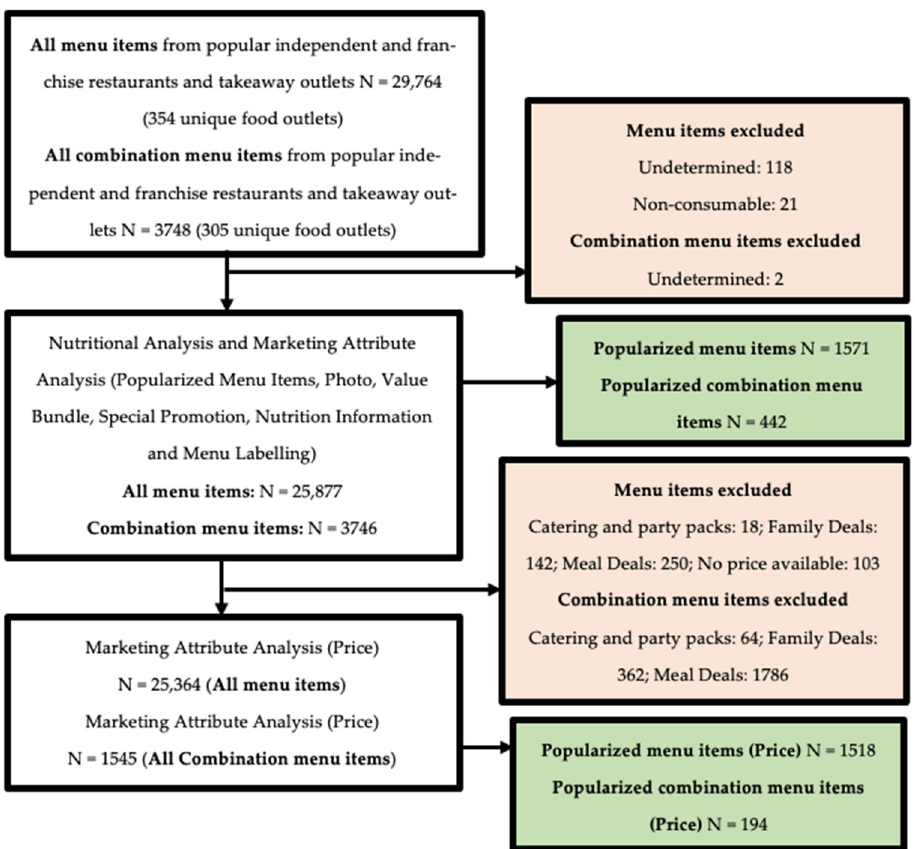
Figure 1. Flow diagram outlining the inclusion of menu items in each analysis.